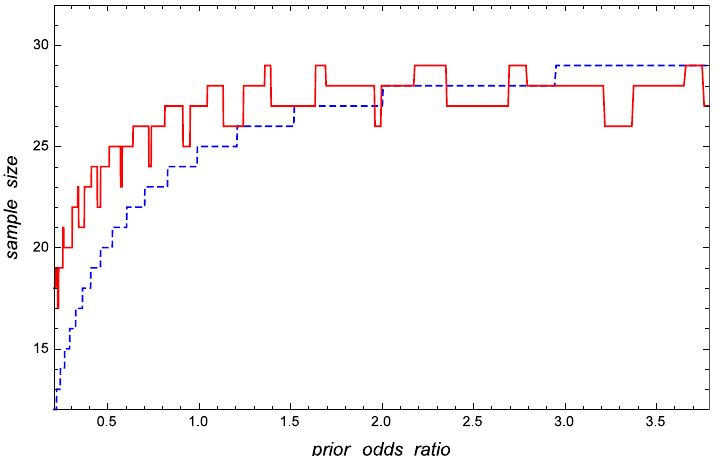
Figure 1. Optimal ( solid line ) and approximate ( dashed line ) sample sizes, n ∗ and n a , versus the prior